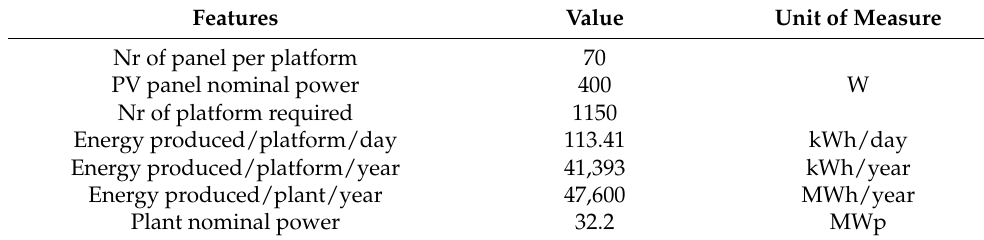
Table 10. Estimation of the annual energy produced. Features Value Unit of Measure